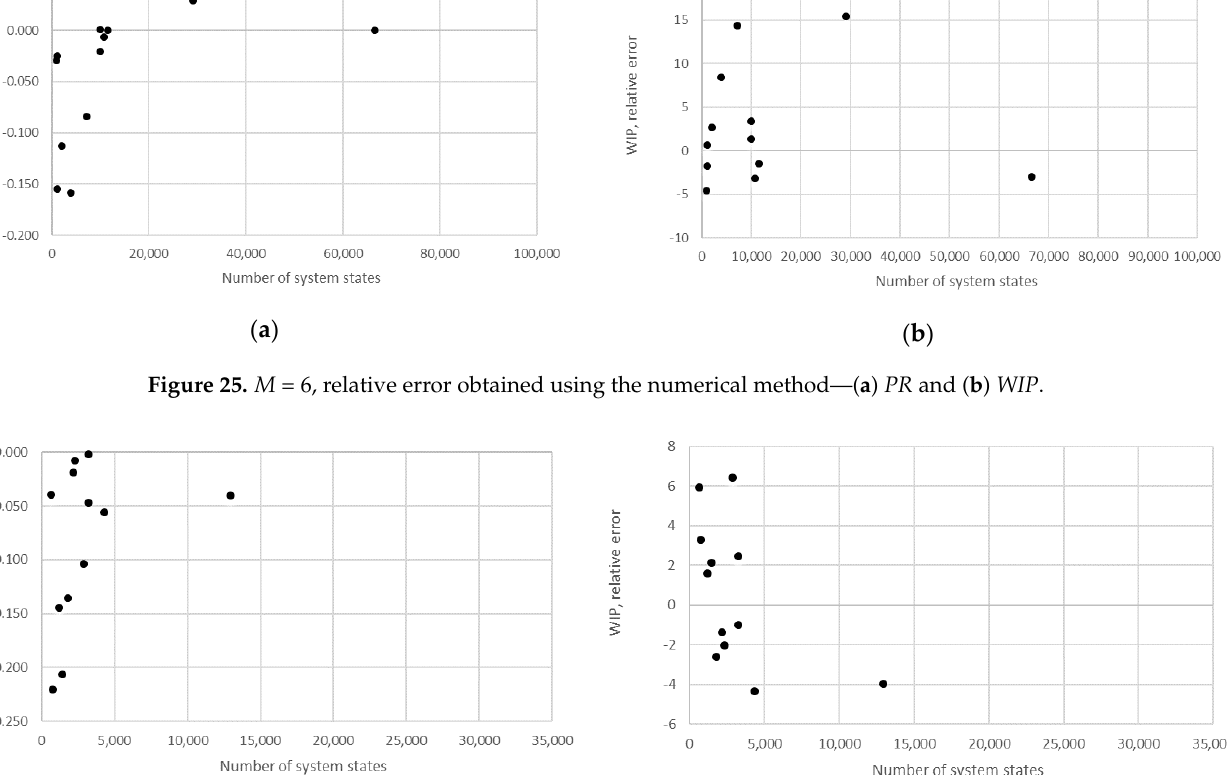
Figure 26. M = 7, relative error obtained using the numerical method—( a ) PR and ( b ) WIP.